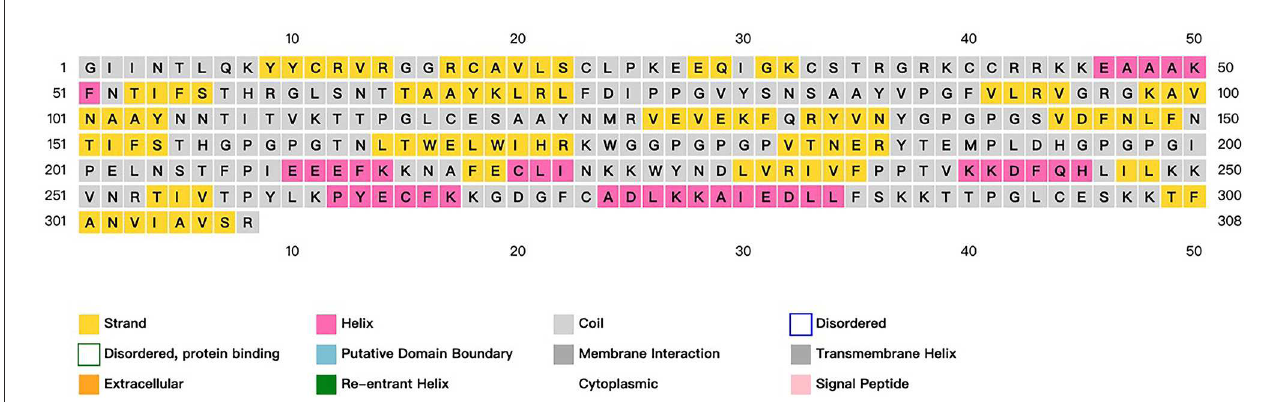
FIGURE5 Secondary structure prediction of SADS-CoV epitopes-based vaccine. Different colors indicate the corresponding information of the secondary structure of the